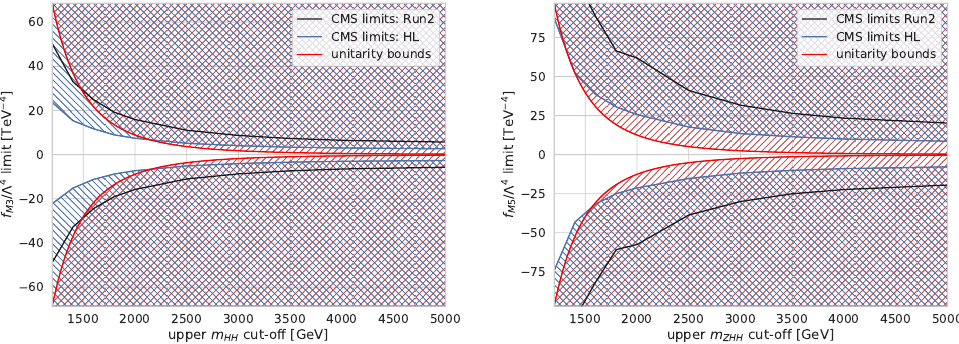
Figure 9 . Estimated limits on the f M3 Wilson coefficient in VBF-HH (left) and f M5 in ZHH (right) as a function of the upper invariant mass cut-off m . Black lines represent the current max Run2 scenario (140 fb − 1 ) while blue lines represent the HL-LHC scenario (3000 fb − 1 ). Superimposed are the unitarity bounds derived from [24] (red lines). The intersection of the experimental and the unitarity-bound curves represents the best limits which can unambiguously be interpreted in an EFT expansion without violating unitarity. While all individual results scale roughly as L − 1 / 4 , the improvement on the EFT-interpretable limit is a factor of